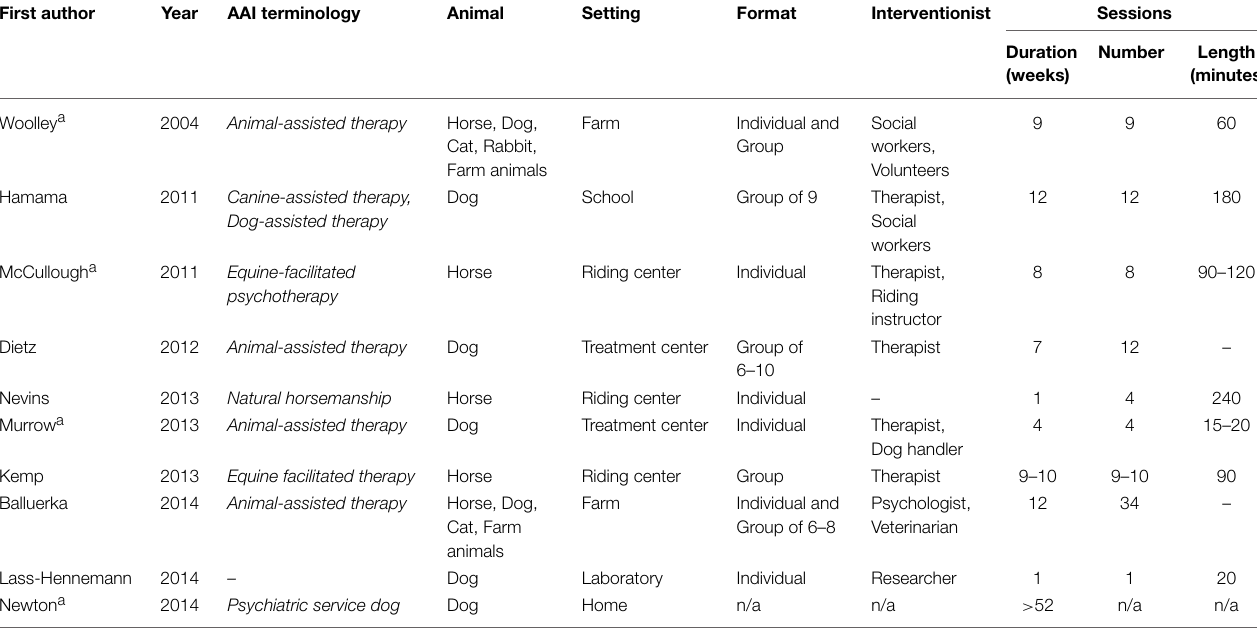
TABLE 2 | Overview of Animal-Assisted Intervention (AAI)